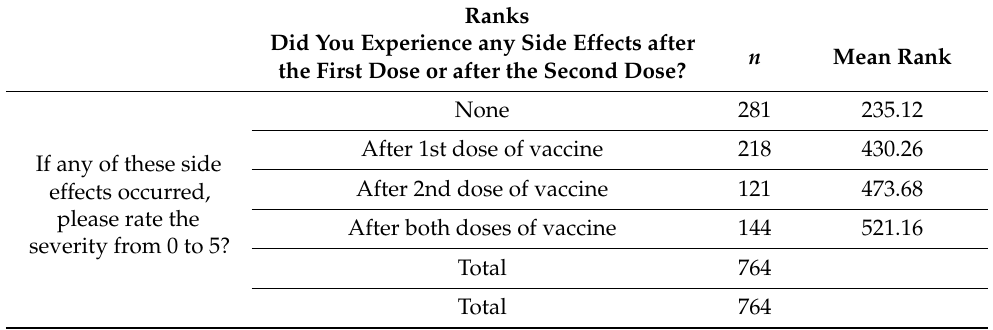
Table 6. Post-vaccination side effects severity rank according to number of doses.